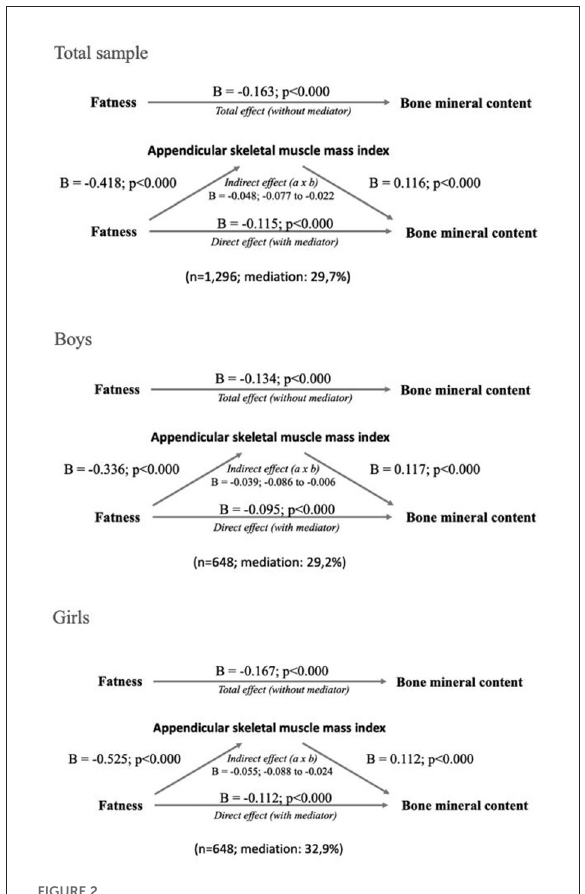
FIGURE2 Total sample and sex-specific mediation analyses. Unstandardized beta values are